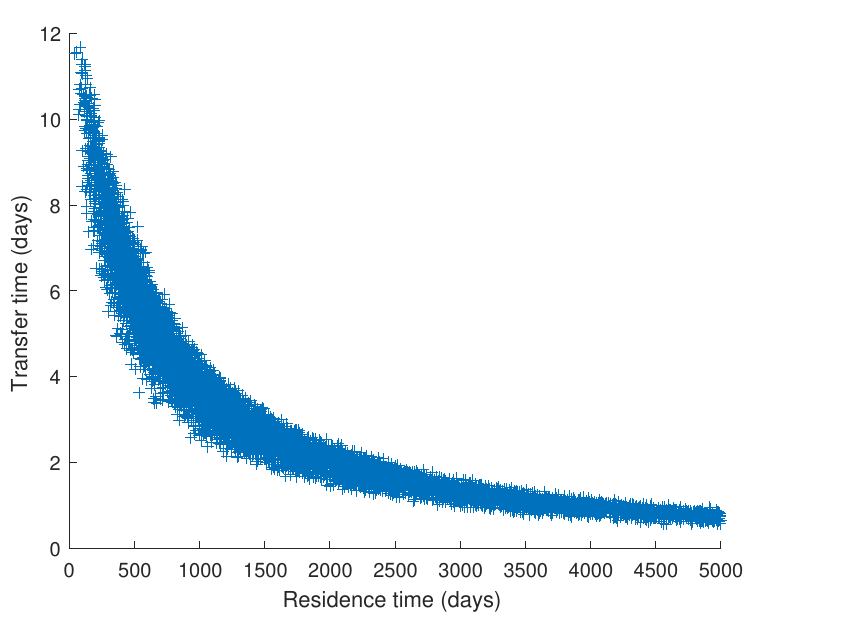
Figure 7. Scatter plot of the dynamic parameters ( τ versus θ ) for which the model can explain the measurements. The histogram of the residence time values peaks between 500 and 1000 days but also extends to the maximum value of 5000 days (Figure 6). The histogram of the transfer time also peaks at low values (between 1 and 3 days) but shows instead that the computation produces no satisfactory results for θ > 12 days. From a statistical perspective, it is thus most likely that measured radioactive disequilibria in the gas plume of Mount Etna are best explained by dynamical parameters in the range 500–1000 days and 1–3 days for τ and θ , respectively. Nevertheless, all satisfactory dynamic